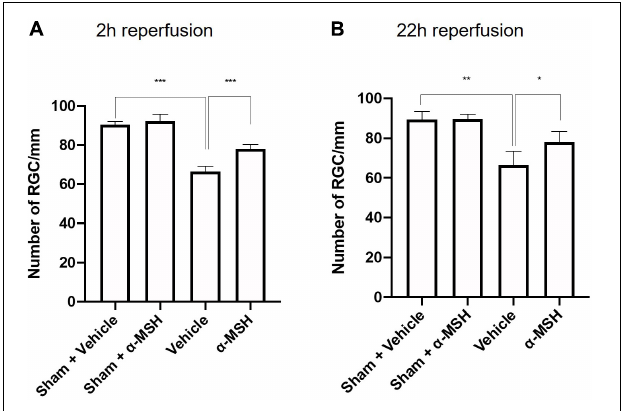
FIGURE 3 | α -MSH maintained the number of RGC in the GCL. (A,B) Significantly lower number of RGC was recorded in vehicle-treated animals compared with α -MSH-treated animals or vehicle-treated sham animals in both experimental conditions. * P < 0.05, ** P < 0.01, *** P < 0.001, One-way ANOVA followed by Tukey’s test, n = 6 for each